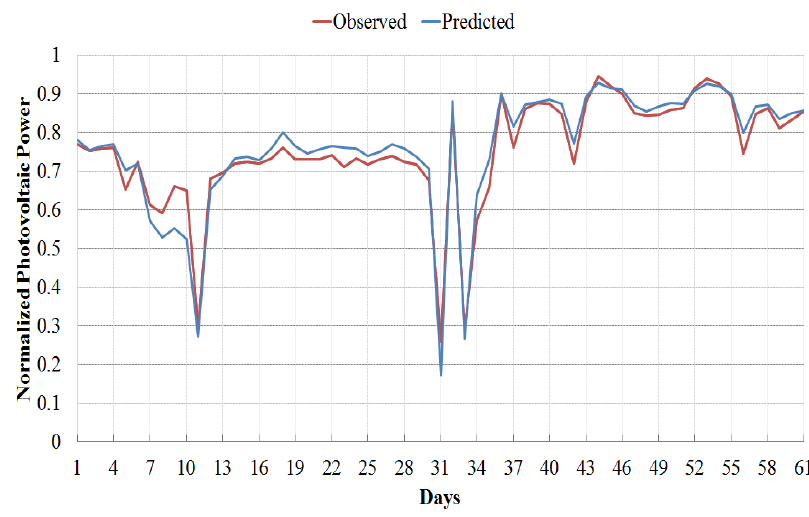
Figure 4. The predicted photovoltaic power values of the GWO-MLP method, which used T A and SR TH inputs.